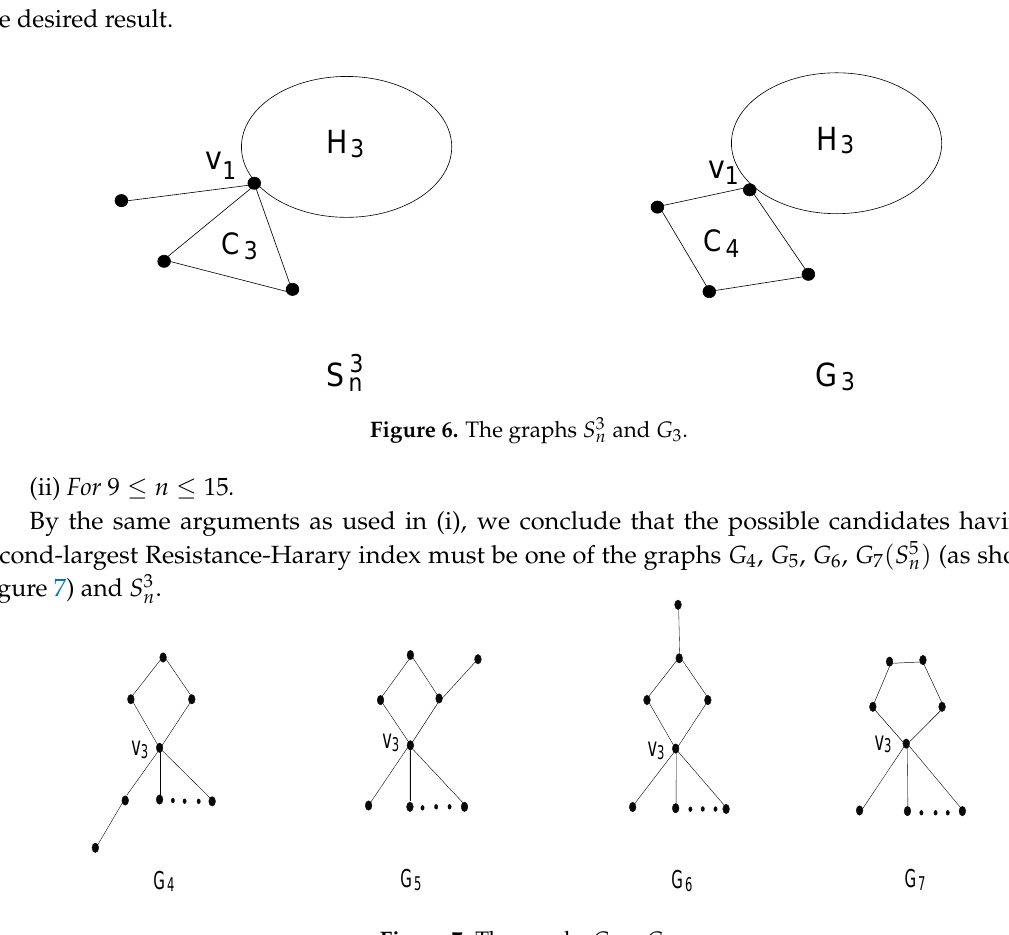
Figure 7. The graphs G 4 − G 7